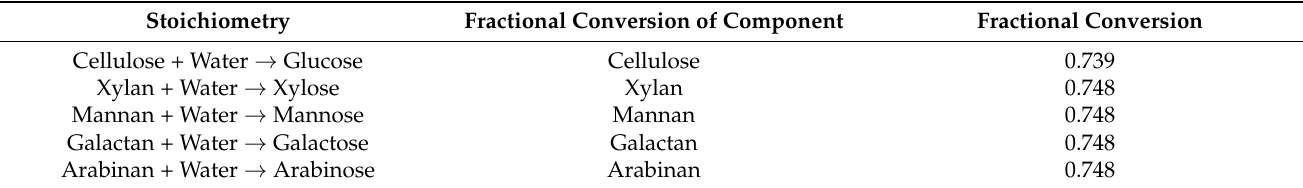
Table 4. Conversion for reaction considered in the enzymatic hydrolysis